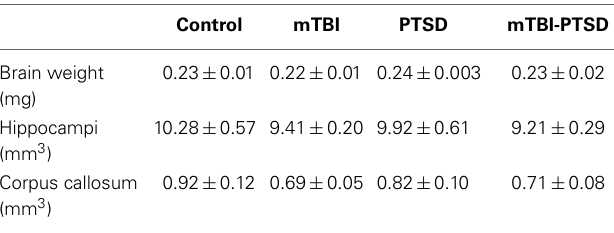
Table 1 | Gross neuropathological changes in the